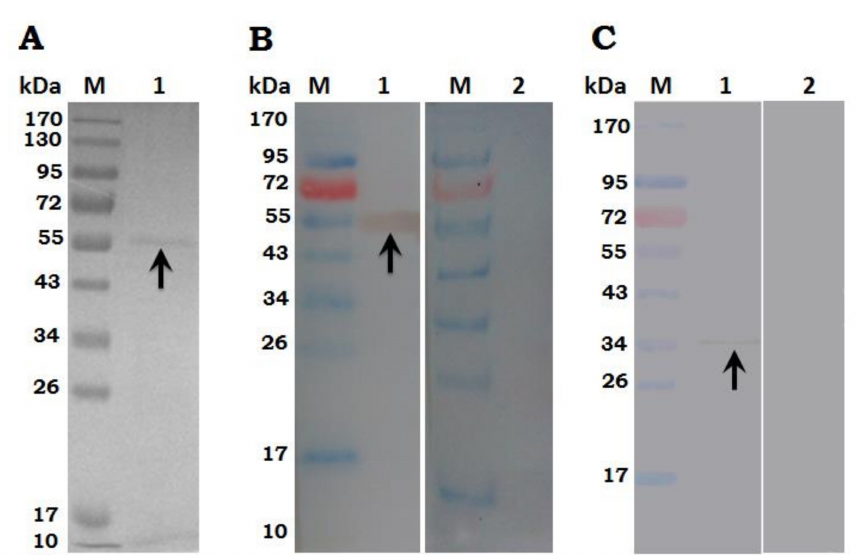
Figure 1. Purification and immuno blot analysis of rHc-TpMy protein. M: molecular weight standard protein Marker. (A) Lane 1: rHc-TpMy protein after isopropyl-ß-D-thiogalactopyranoside